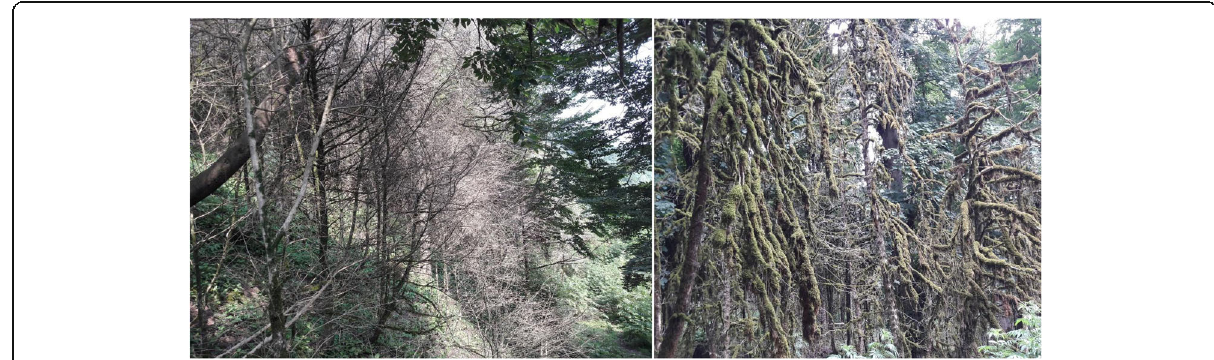
Fig. 1 General view of B. hyrcana in Hyrcanian forests that have been infected by boxwood blight (caused by Calonectria pseudonaviculata , syn. Cylindrocladium pseudonaviculatum , Cy. Buxicola ); Tuscatoc (right) and Escolac